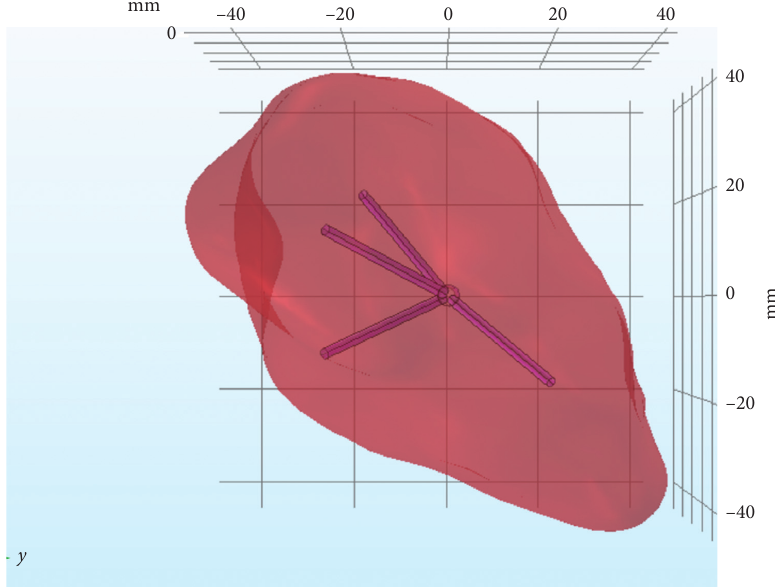
Figure 17: Front view of hematoma